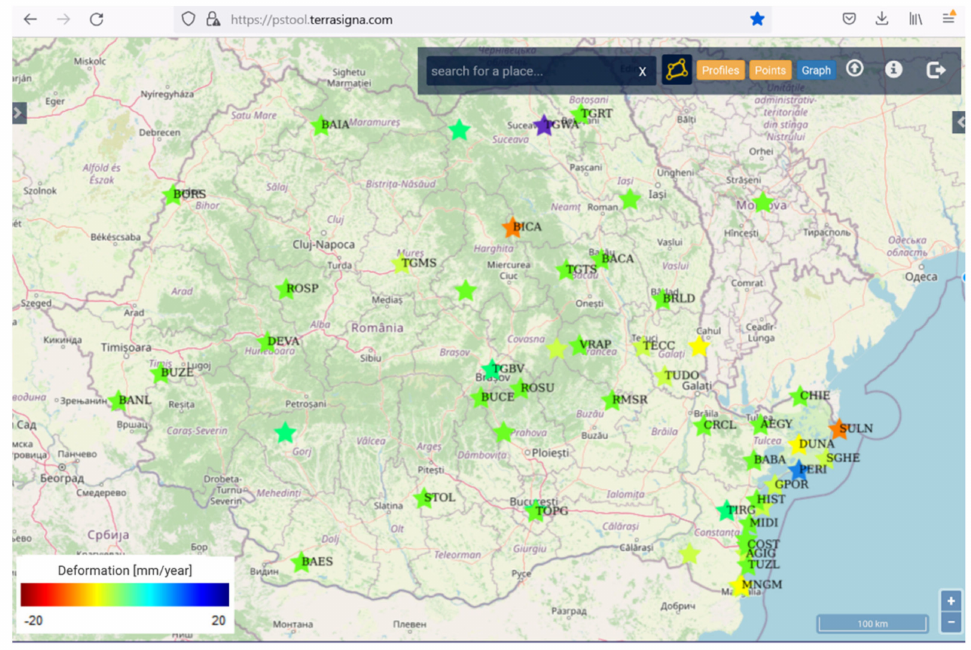
Figure 4. Permanent GNSS stations in Romania. The color represents the yearly vertical displace- ment